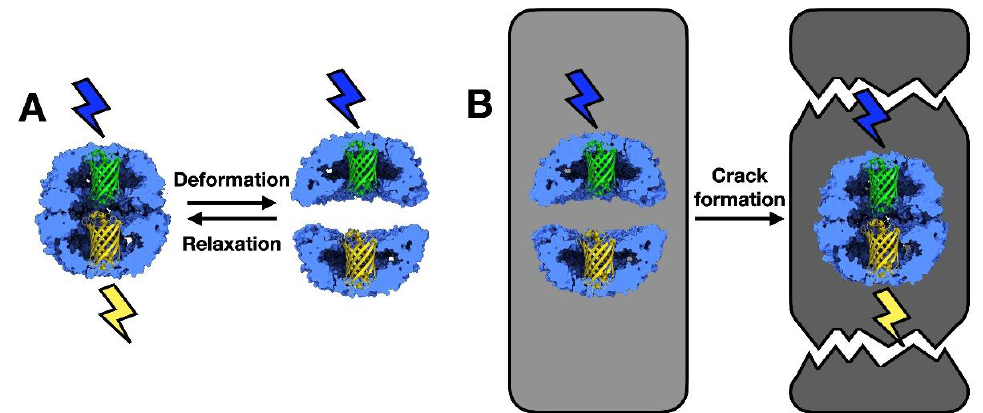
Figure 4. Type II chaperonins used as nanosensors. ( A ) Deformation of a fluorescence-modified chaperonin increases the distance between the donor–acceptor pair, which reduces the FRET signal. ( B ) A fluorescence-modified chaperonin is embedded in a polymer and undergoes polymerization and drying stress. Crack formation induces relaxation in the polymer and chaperonin, which can be detected by changes in the emission intensity of the FRET acceptor complex. The two images are modified from [31].